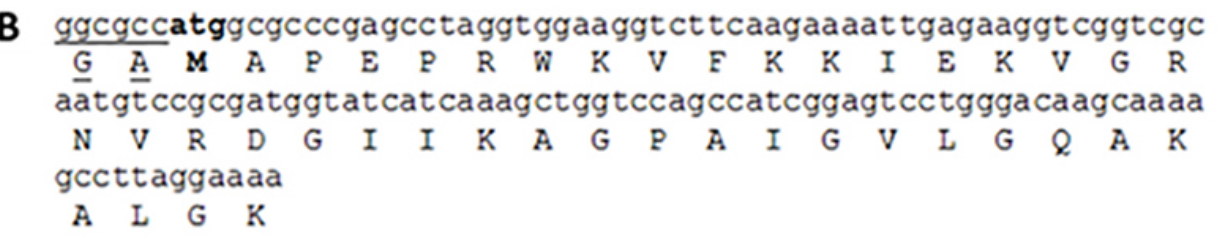
Figure 1. (A) Cecropin B-like peptide sequence identified in A. gemmatalis midgut transcriptome. Signal peptide sequence (underlined in red) was detected using SignalP software. Underlined nucleotides were used for primer design. Pro region peptide is in italic. (B) Recombinant cecropin B-like (AgCecropB) sequence, with remaining residues from TEV cleavage site (underlined in black) and NcoI restriction site